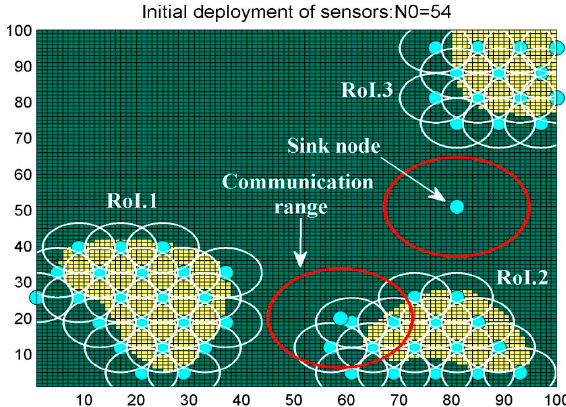
Figure 12. Initial sensor deployment “Scenario 1”.